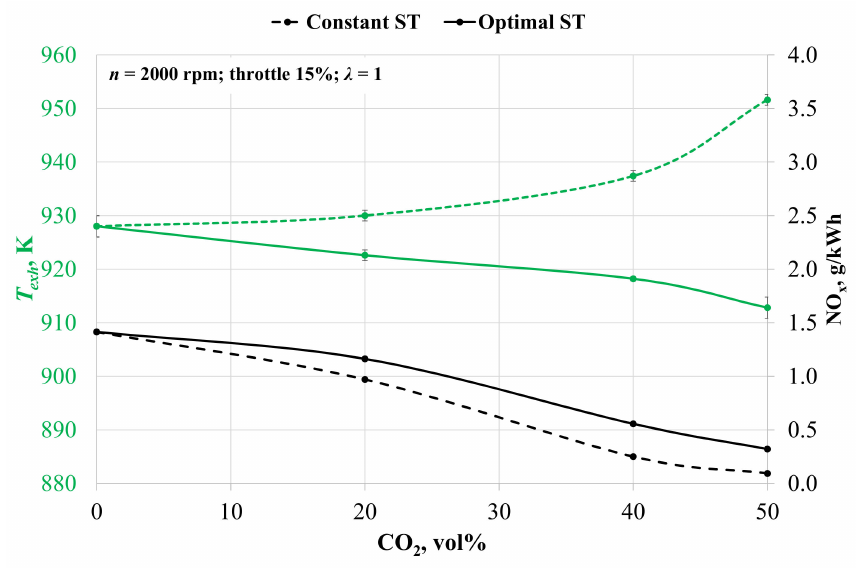
Figure 6. Change of the exhaust gas temperature and NO x concentration in exhaust gas depending on the volumetric fraction of CO 2